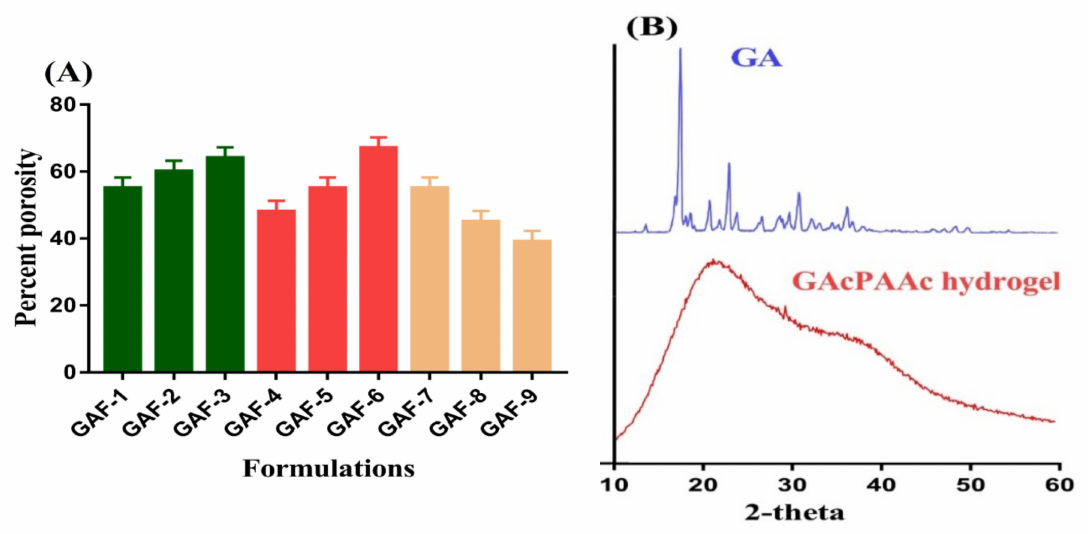
Figure 6. ( A ) Percent porosity and ( B ) PXRD of GA and GAcPAAc hydrogel.